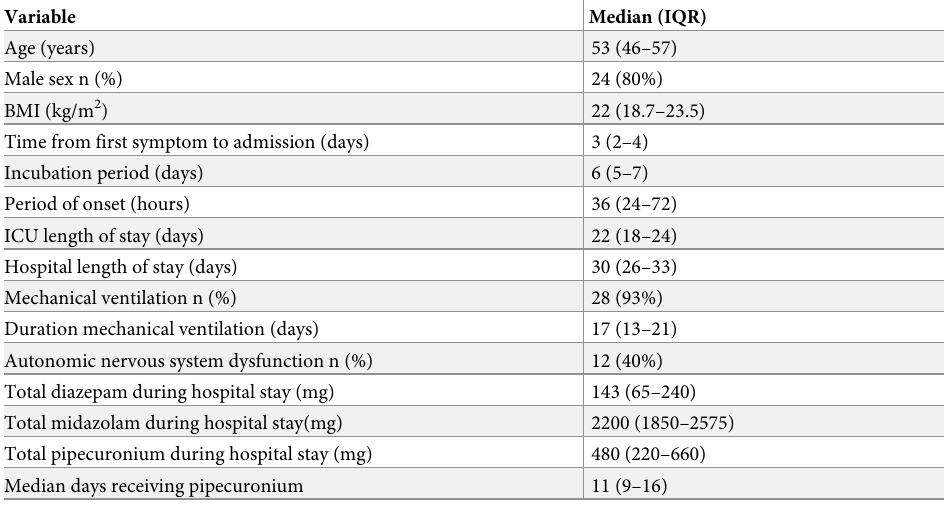
Table 1. Participant